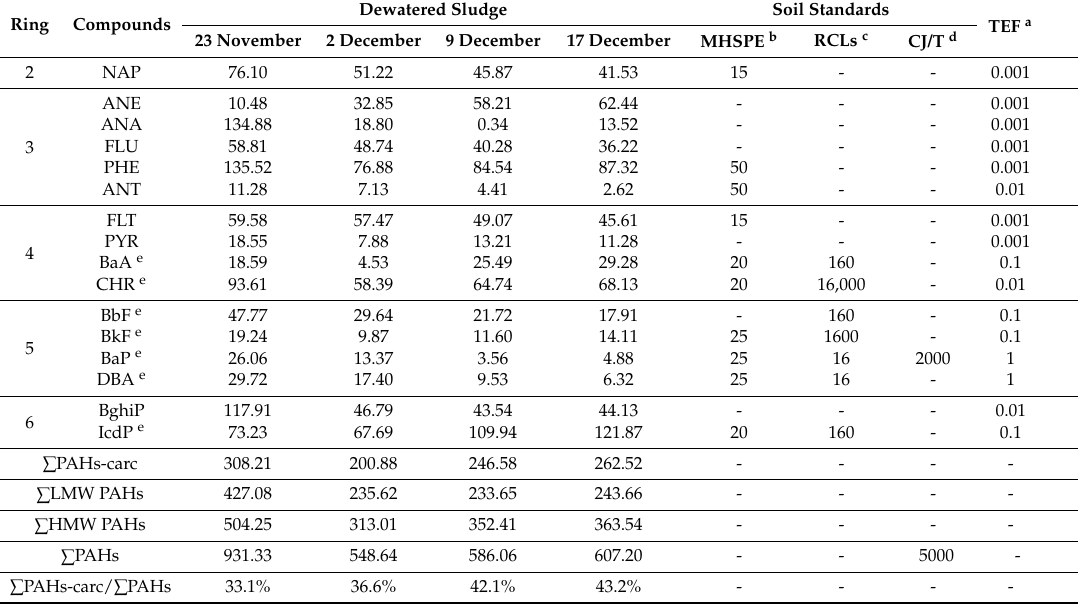
Table 2. Concentration of PAHs in dewatered sludge (ng/g), soil standards (ng/g), and toxic equivalent factors.